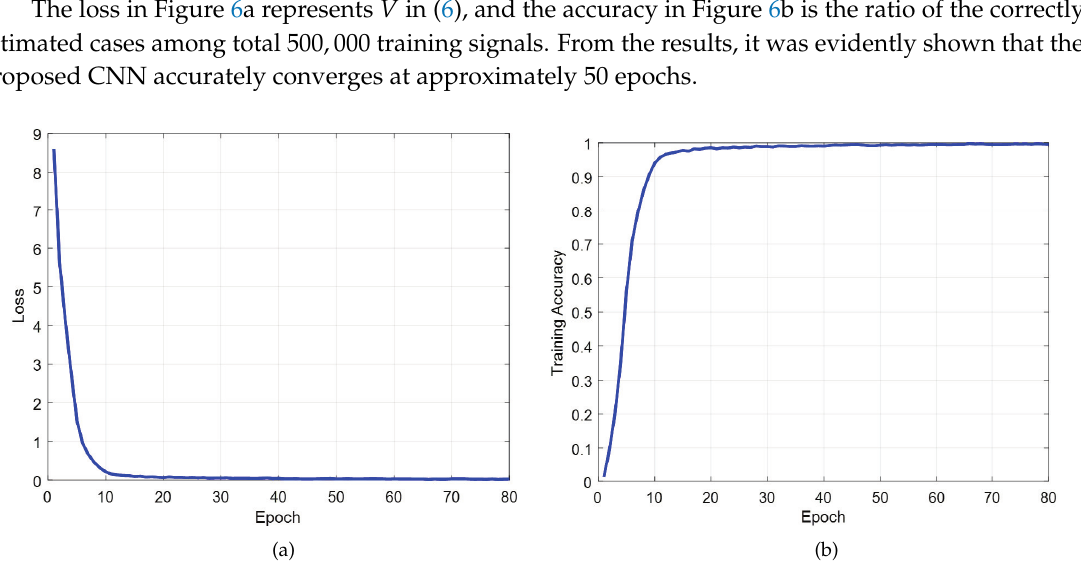
Figure 6. Learning curves for ( a ) loss and ( b ) training